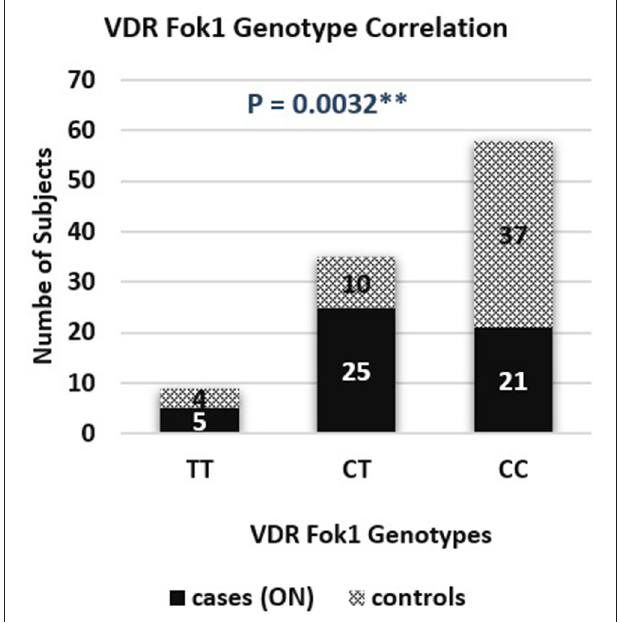
FIGURE 4 | VDR fok1 genotype correlation bar chart in osteonecrosis cases and controls.